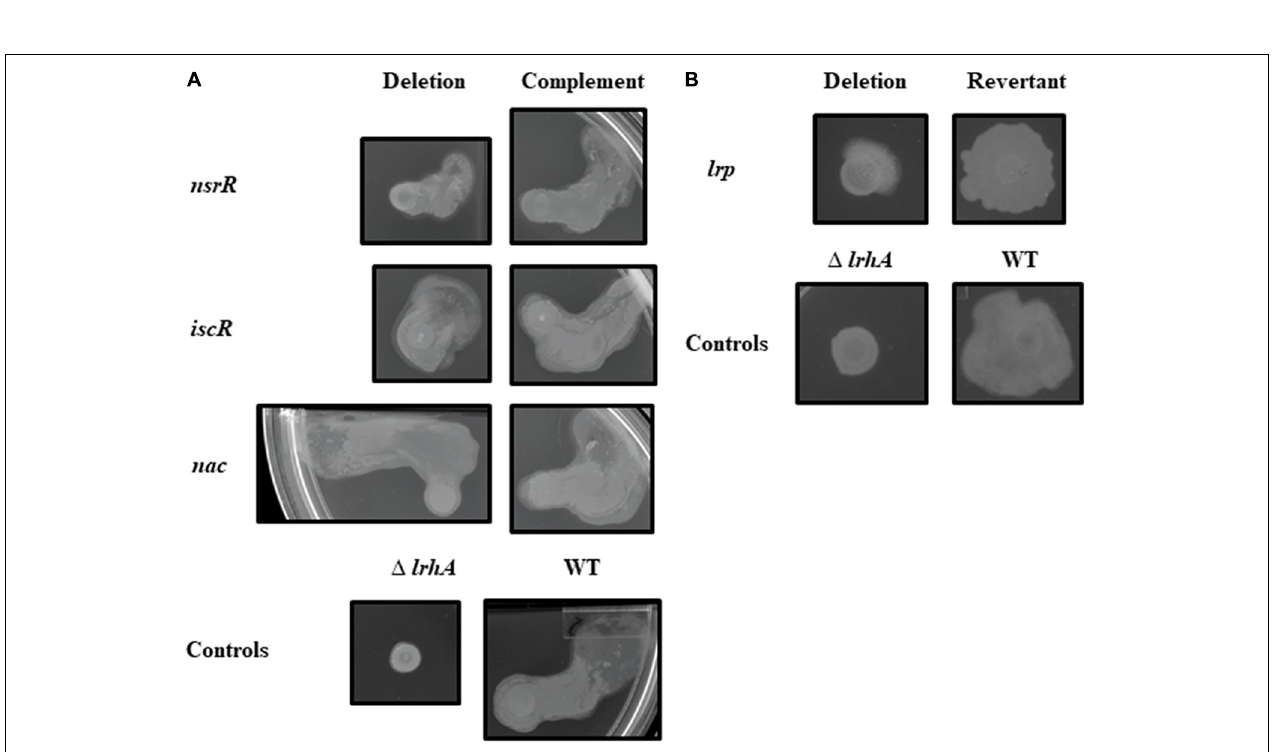
FIGURE 2 | Surface motility of P. stewartii nsrR , iscR , nac , and lrp mutant and complementation or revertant strains. All photographs, representative of duplicate or more samples, were taken at the same magnification after incubation in 30 ◦ C on LB medium (0.4% agar, 0.4% glucose) for 48 h (A) or 72 h (B) for the indicated